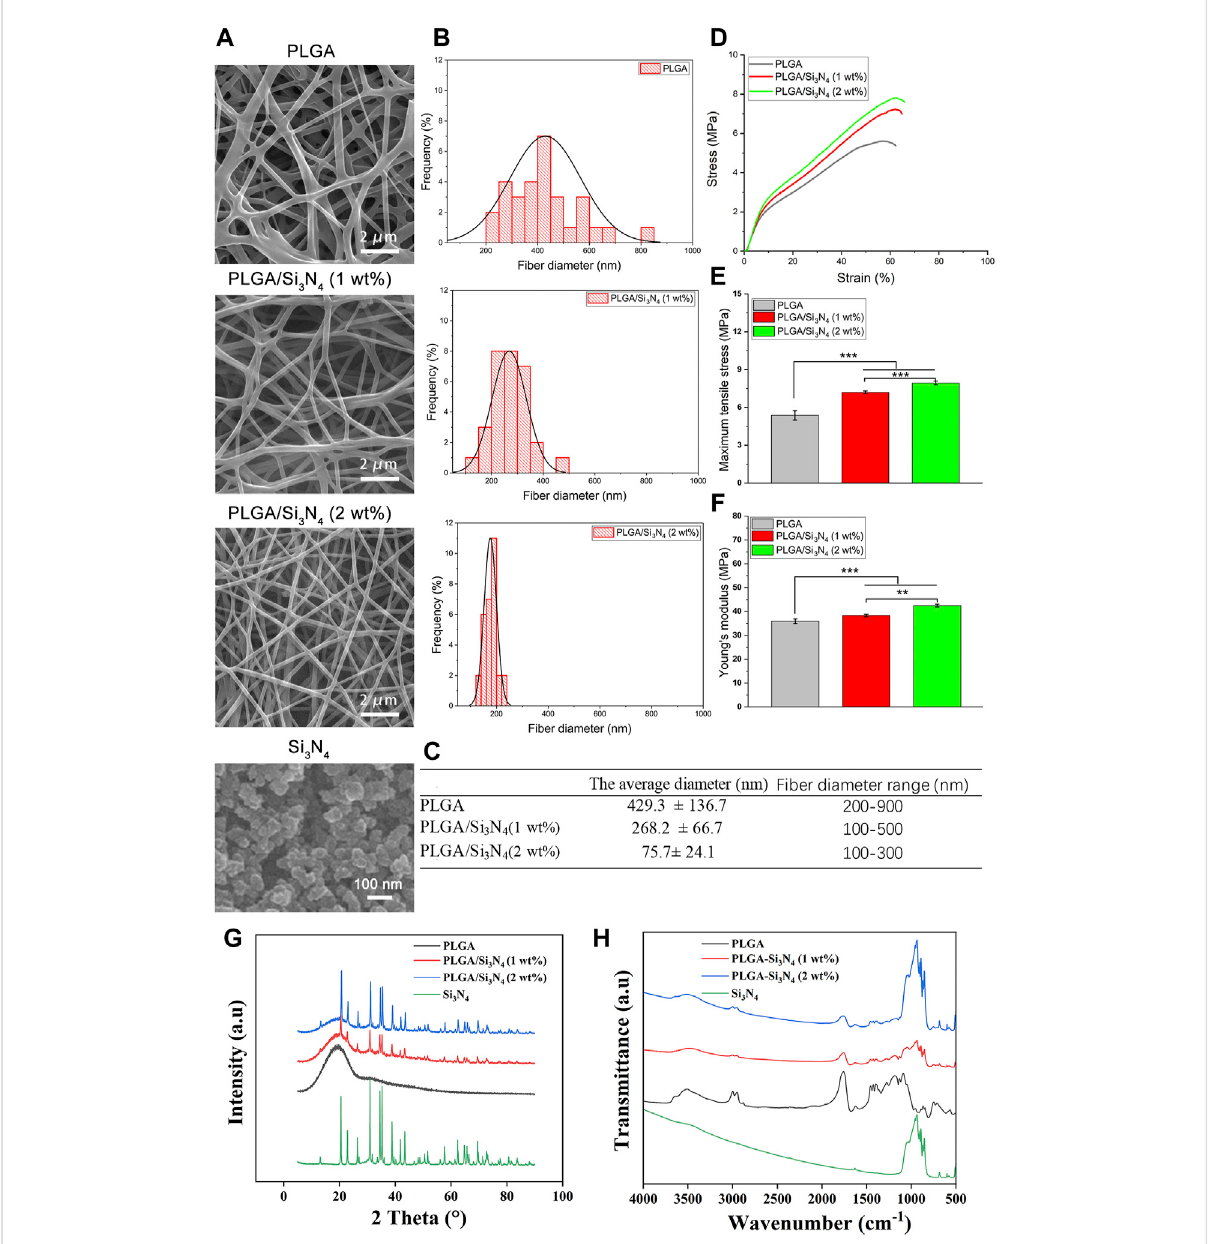
FIGURE 2 Characterization of the PLGA nano fi ber scaffold, PLGA/Si 3 N 4 (1 wt.%) nano fi ber scaffold, and PLGA/Si 3 N 4 (2 wt.%) nano fi ber scaffold. (A) SEM images of the electrospinning fi brous scaffolds and Si 3 N 4 . Scale bar: 2000 nm. (B) distribution of fi ber diameters in the nano fi ber scaffolds. (C) average fi ber diameter of the nano fi ber scaffolds. (D) typical tensile stress-strain curves of the nano fi ber scaffolds. (E) maximum tensile stress of the nano fi berscaffolds. (F) Young ’ smodulusofthenano fi berscaffolds. (G) XRDand (H) FTIRresultsfordifferentgroupsofSi 3 N 4 ,PLGA,PLGA/Si 3 N 4 (1 wt.%), and PLGA/Si 3 N 4 (2